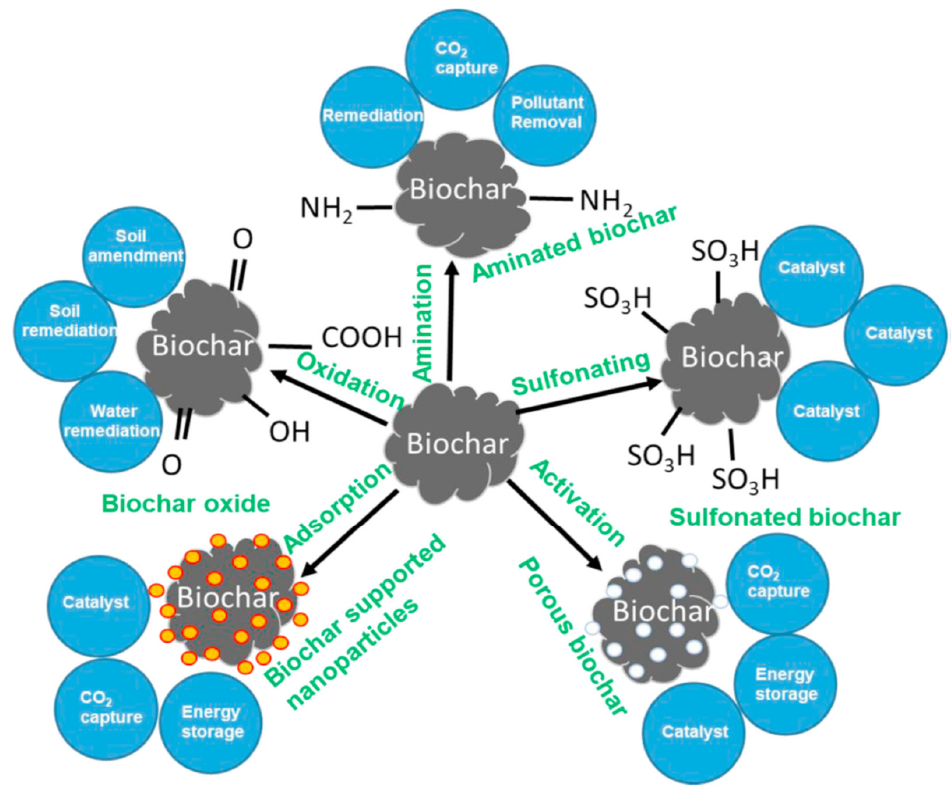
Figure 1. Biochar potential applications of different sectors. Figure 1. Bio-char potential applications of different